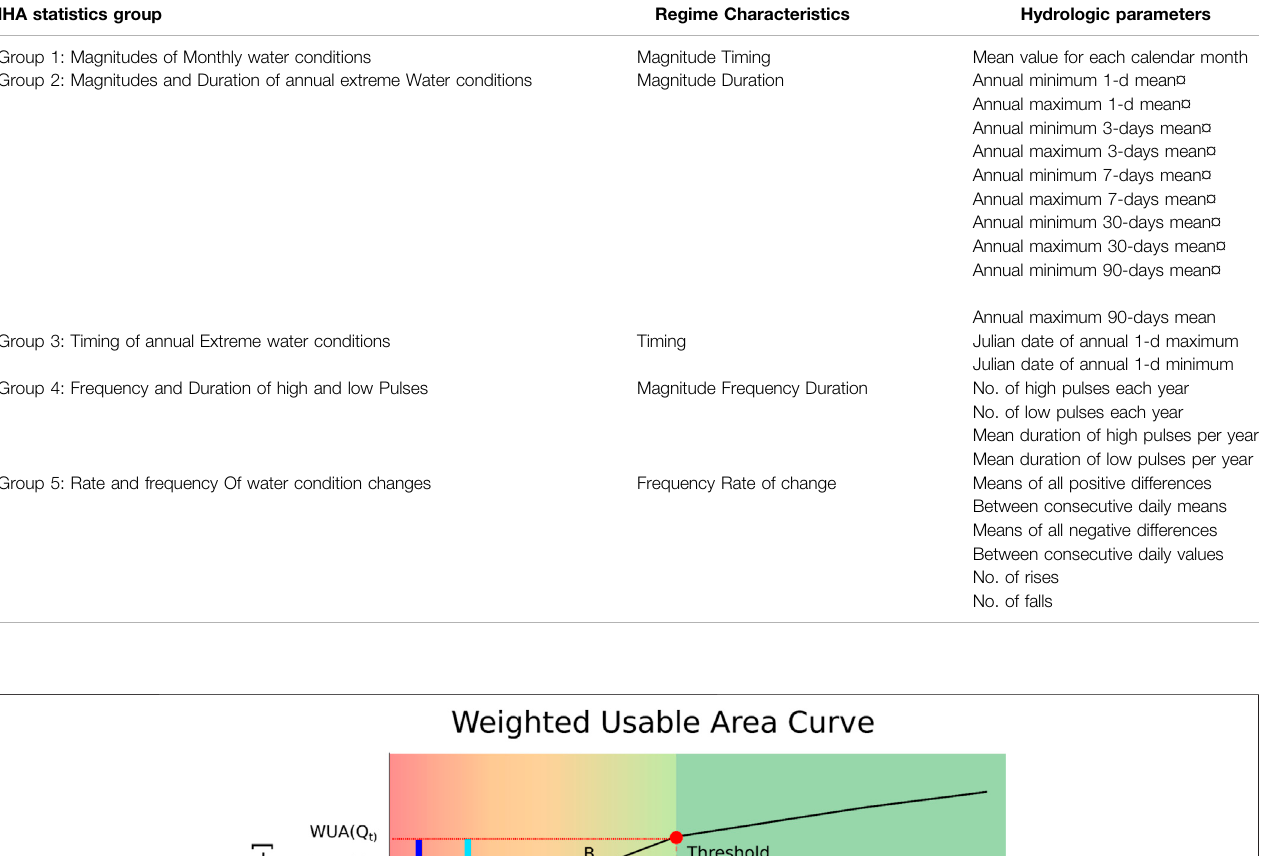
TABLE 1 | Summary of hydrological parameters used in the Indicators of Hydrologic Alteration and their characteristics.